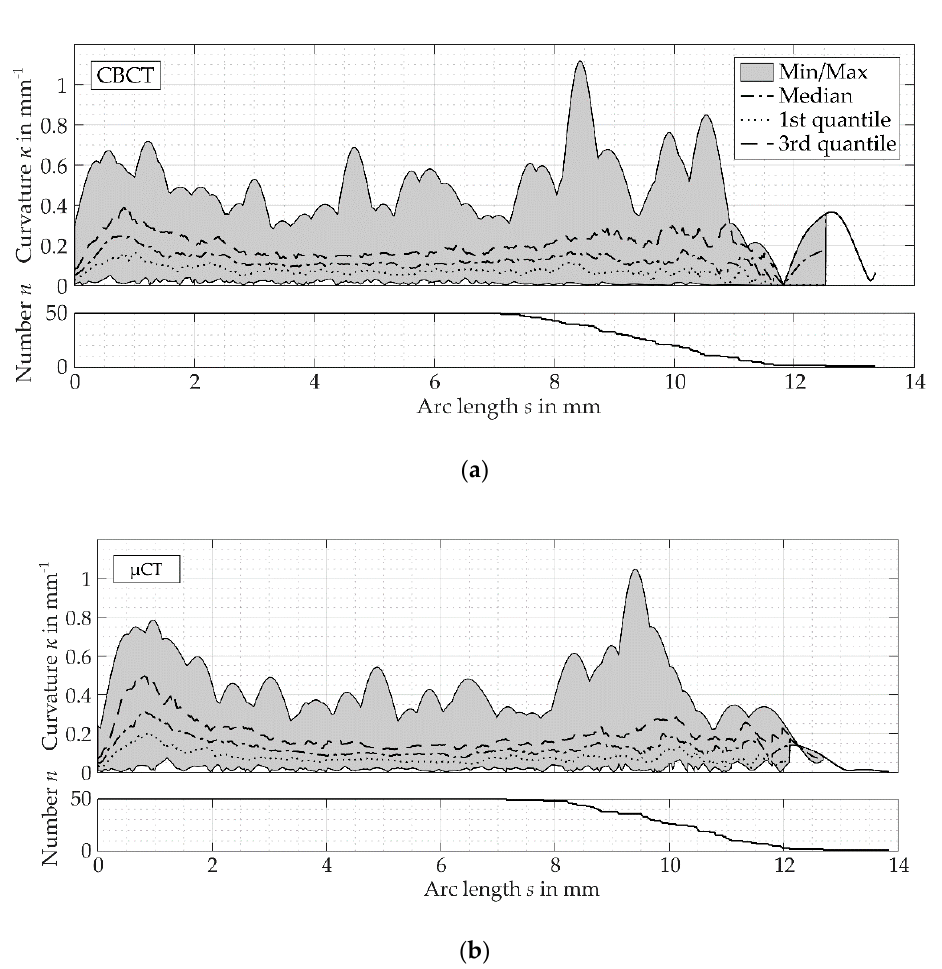
Figure 7. Measurements of root canal curvature 𝜅(𝑠) and the number 𝑛(𝑠) of root canals with a maximum length up to this point 𝑠 calculated by means of: ( a ) CBCT images, ( b ) µCT images. The values of maximum curvatures evaluated from CBCT images were 17% smaller than the results obtained by means of µCT images (Table 3). The maximum curvatures derived from CBCT and µCT images were located with the highest probability in the apical third and with the second highest probability in the coronal third. The medial part represented the section with the smallest curvatures. Table 3. Median and quartile deviation of the maximum curvatures and its relative probability in the different thirds ( 𝑛 = 50). Imaging Technique Maximum Curvature